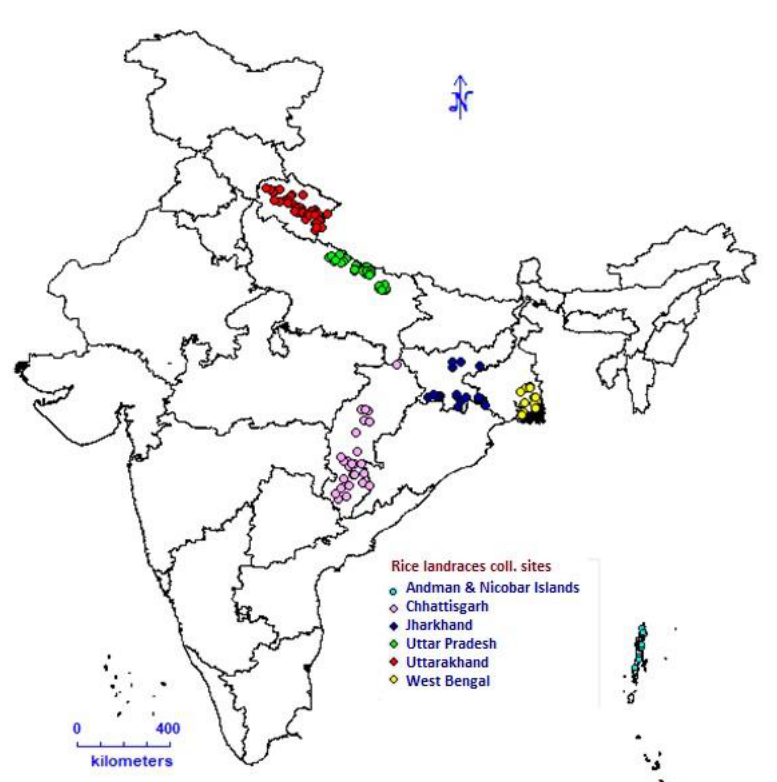
Figure 1. Map of India showing the locations where rice collection was conducted.